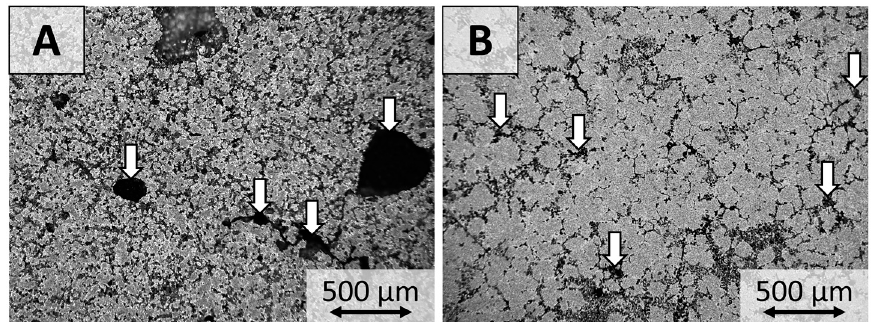
Figure 10. Optical microscope images. White arrows show particles into the alloy. ( A ) without electromagnetic processing, particles are in agglomerates; ( B ) with pulsed electromagnetic field